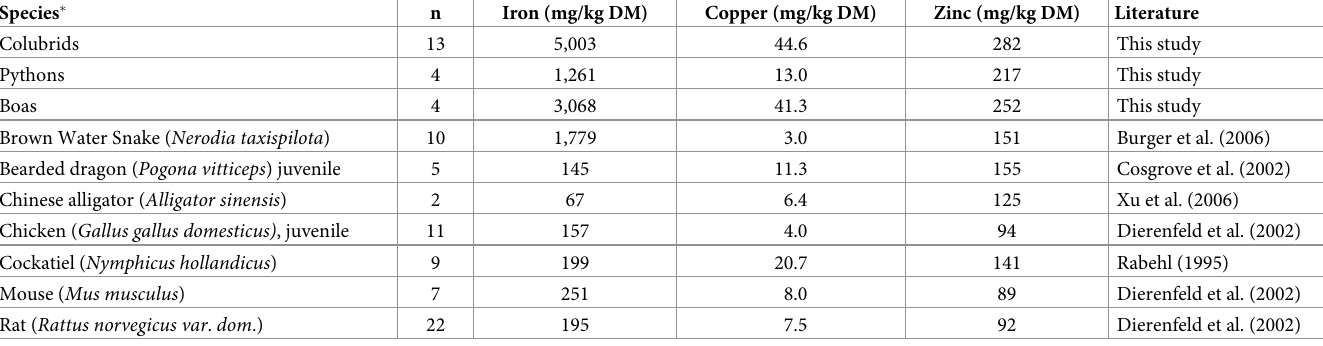
Table 10. Comparison of whole-body iron, copper and zinc content of different reptilian, avian and mammalian species. Species �